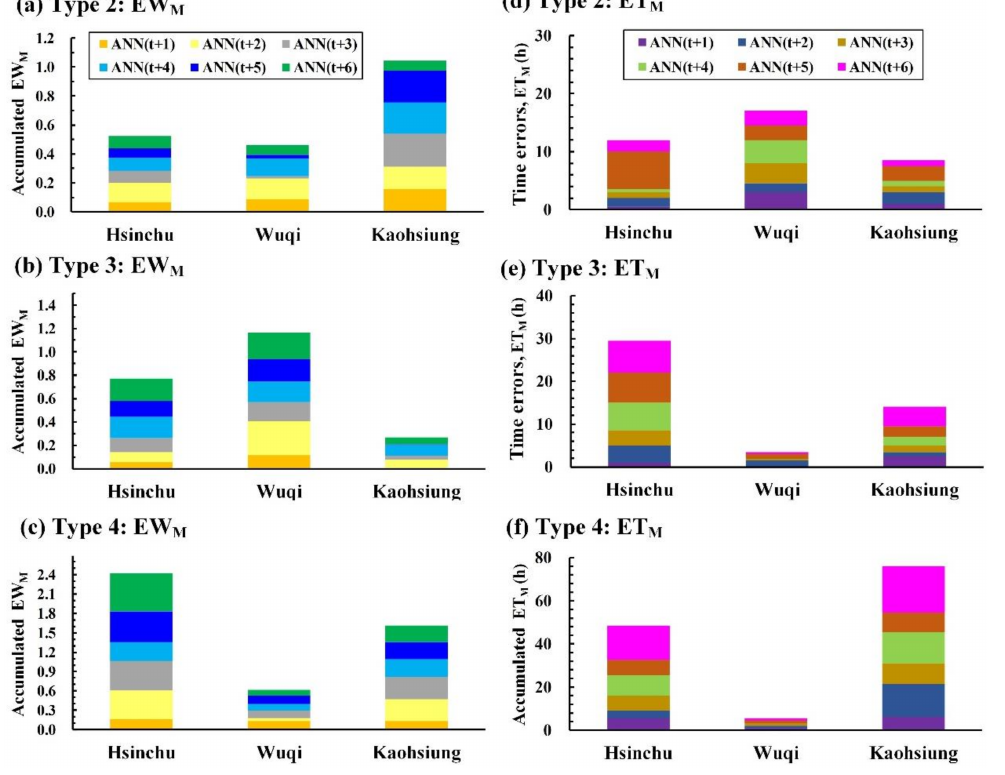
Figure 15. Performance of ( a – c ) accumulated EW M for track Types 2, 3, and 4, respectively, and ( d – f ) accumulated maximal wind time error (ET M ) for Types 2, 3, and 4,